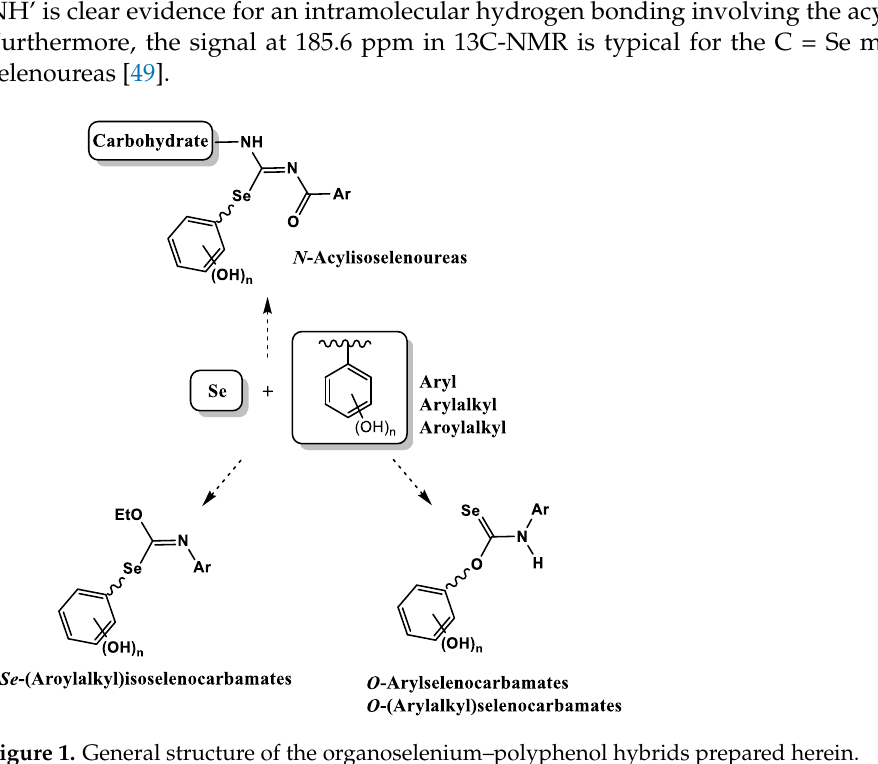
Figure 1. General structure of the organoselenium – polyphenol hybrids prepared herein.